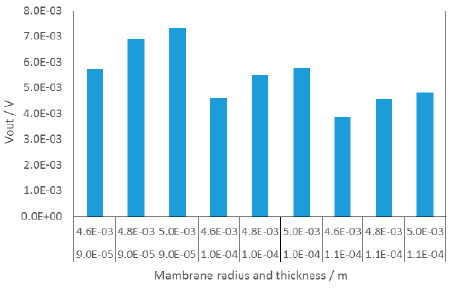
Figure 5. Results of parametric analysis of 100 mbar sensor.